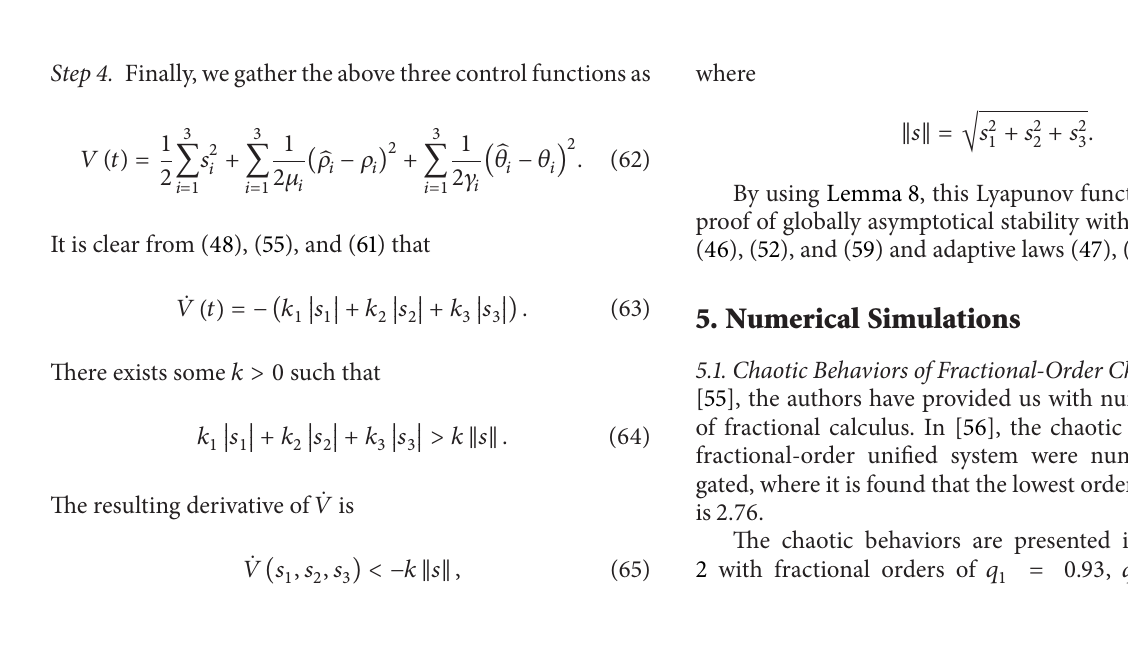
Figure 1: Chaotic trajectories with 𝛼 = 0.5